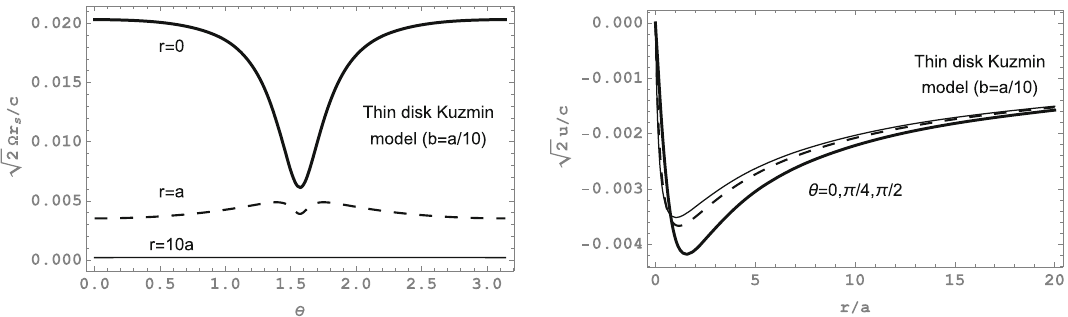
Fig. 3 Normalized angular velocity and rotation velocity profiles for an hypothetical dust distribution represented approximately by the thin disk Kuzmin model. Note that the radial distance to the axis of rotation is R = r sin θ